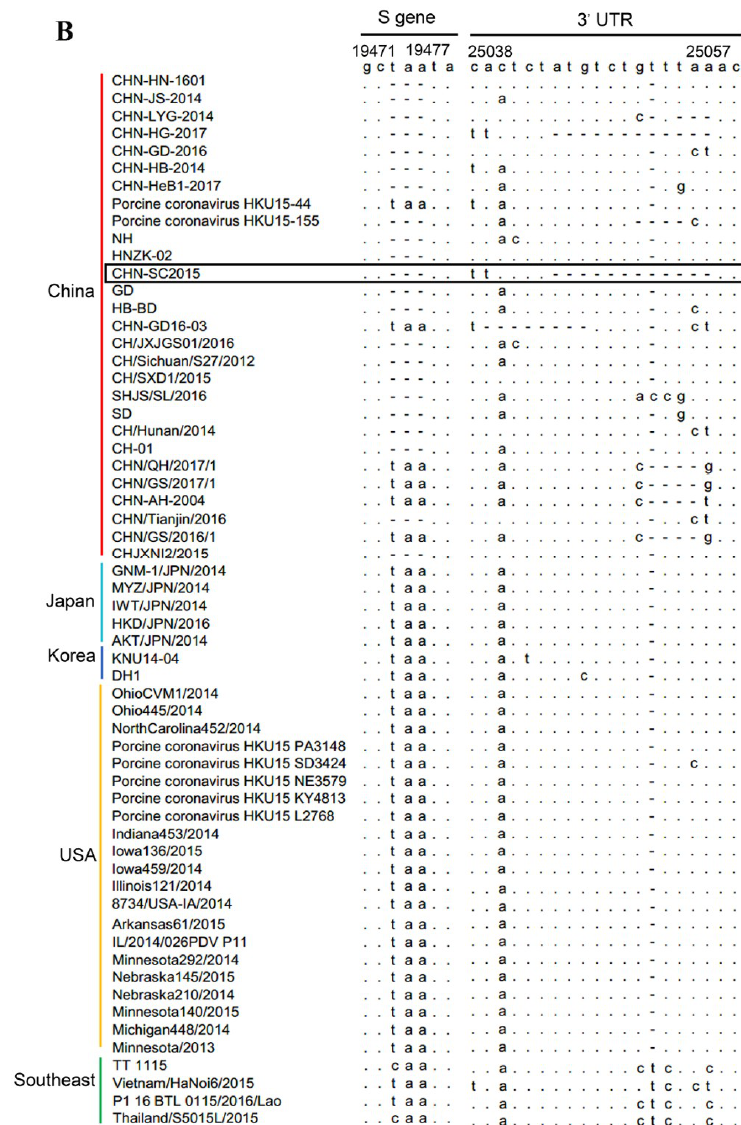
Figure 5. Analysis of deletions and insertions in the complete genome of PDCoV strain CHN-SC2015. Alignments, ORF1ab gene ( A ) and the S gene and 3′ UTR ( B ) were performed with ClustalW software in MEGA X. PDCoV strain CHN-SC2015 is outlined with a box. A dash indicates that the deleted nucleotide is present in the other 59 sequences compared to the consensus sequences.